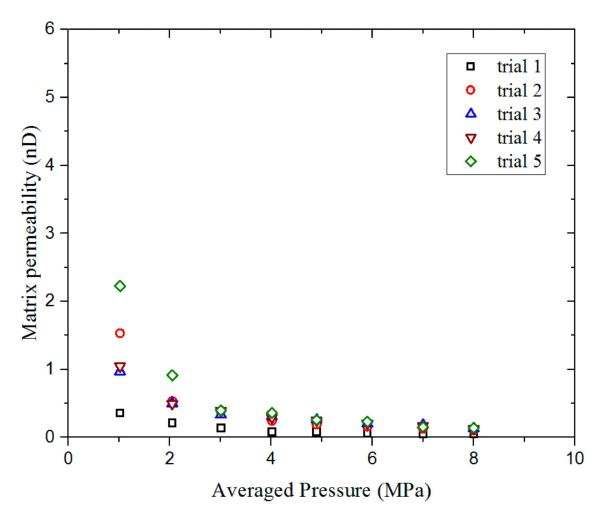
Figure 5. The results of the repeatability experiment, involving five trials, using sample 1 under pressures of 1–8 MPa.